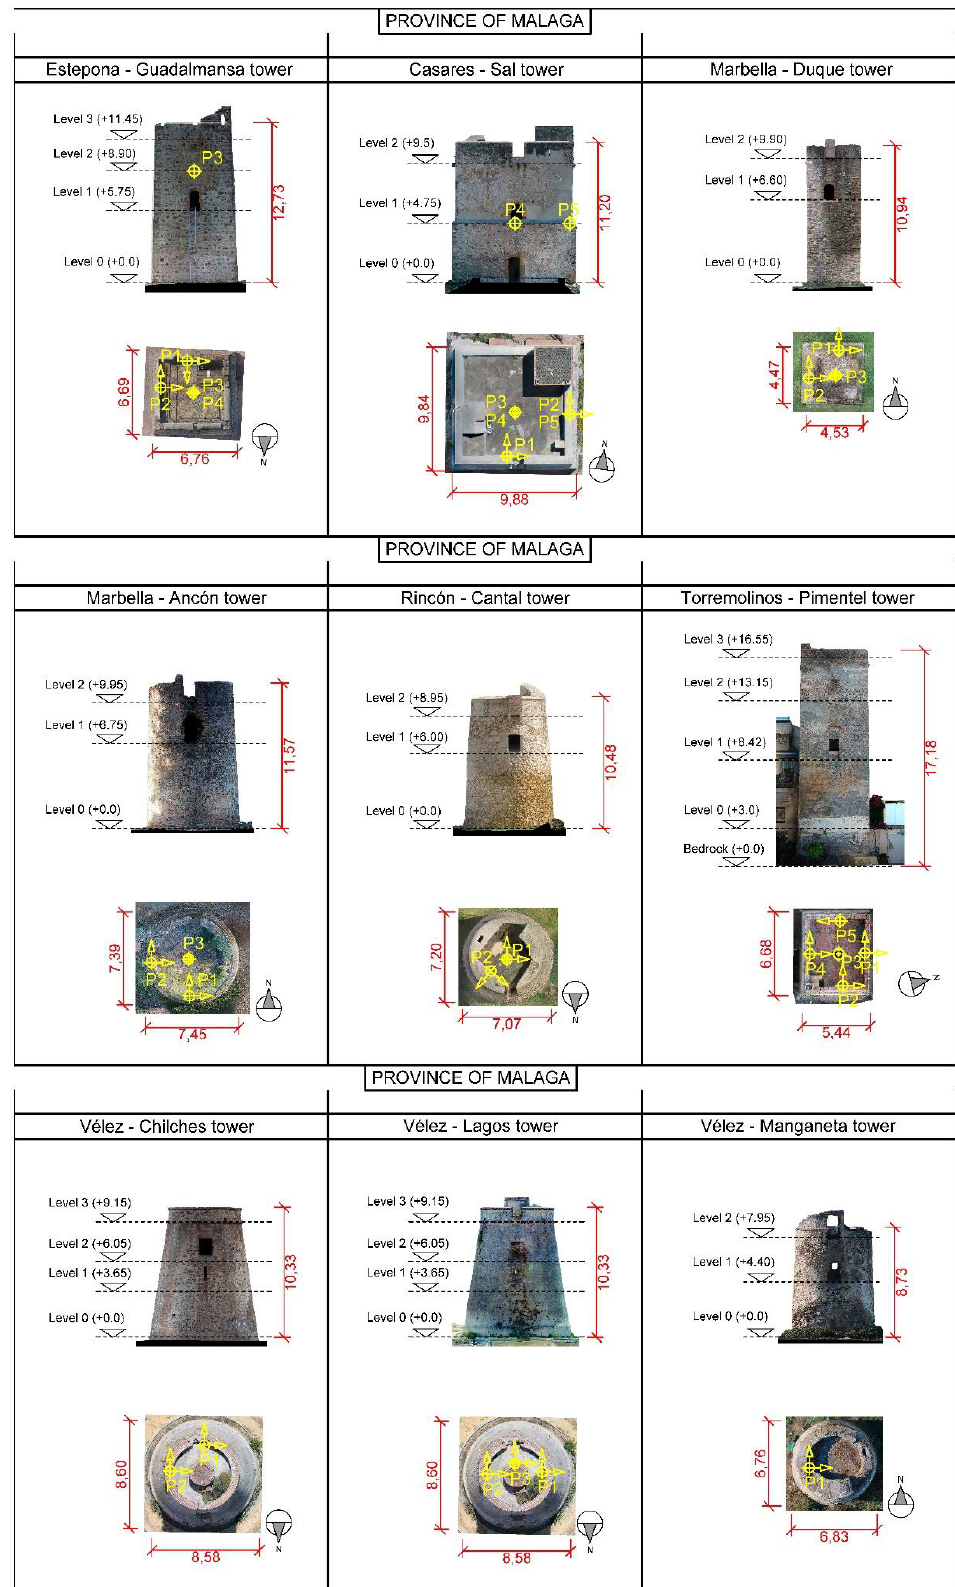
Figure 10. Points where ambient vibration testing was carried out. Towers are sorted by the provinces where they are located — Granada, Almeria and Malaga, — and by municipality.